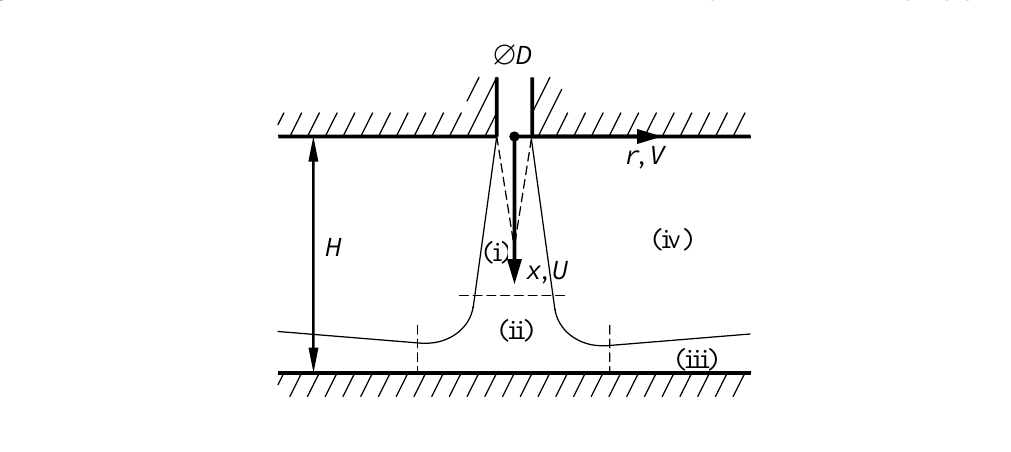
Figure 2 identifies four distinct regions in the flow field: (i) the free jet with a decaying potential core in the centre and surrounding shear layer, (ii) the stagnation region, (iii) the wall jet and (iv)